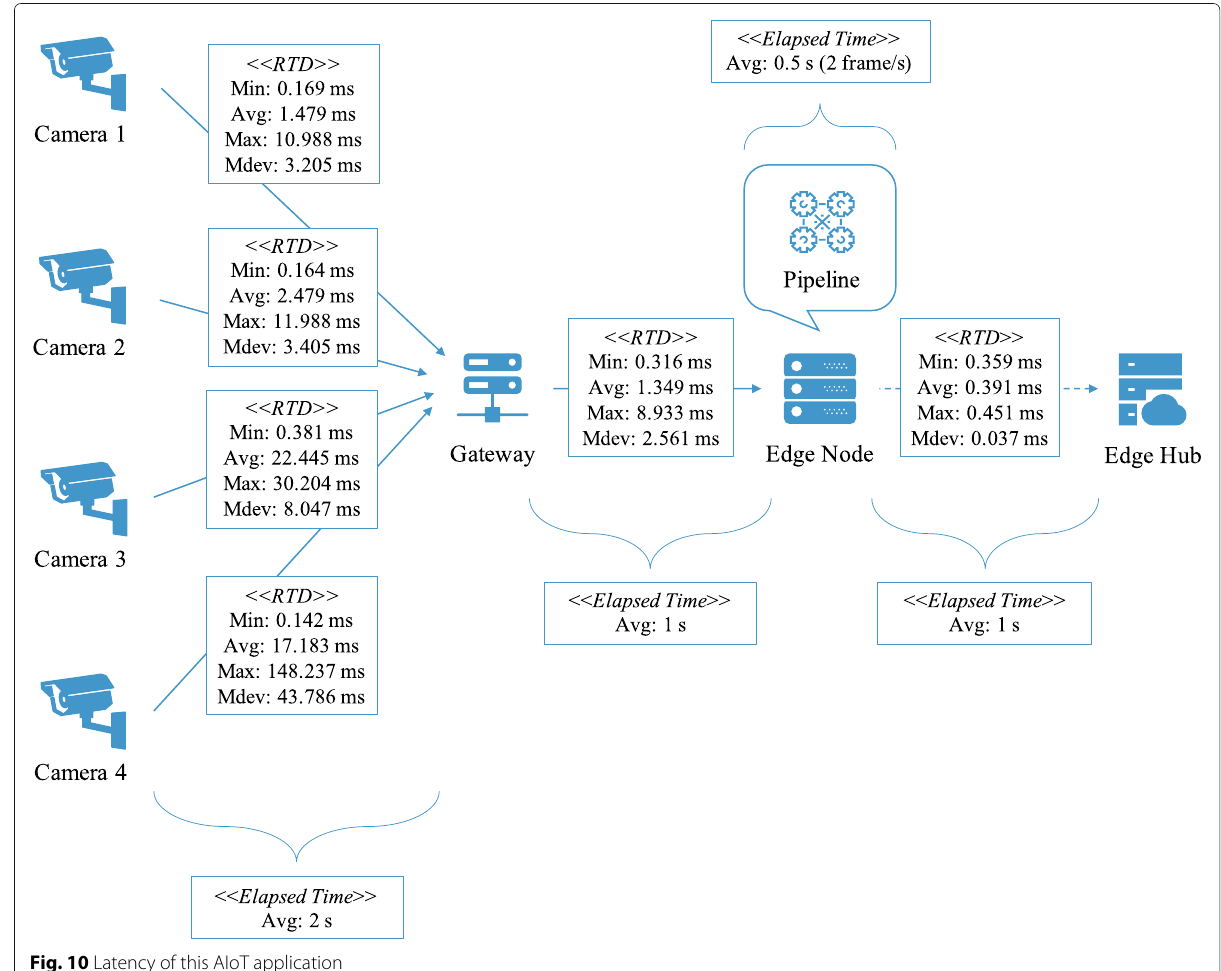
on the Edge Hub and delivered to the Edge Nodes later on. The model warehouse stores all the trained models as container images that can be quickly deployed on the Edge Nodes. The aforementioned products are also managed on the Edge Hub since the definition of products are usually able to be shared by all the Edge Nodes in a single AIoT application. The cloud infrastructure takes the responsi- bility for computing, as it usually integrates a big data backend (e.g. Spark) for data processing as well as an AI backend (e.g. Tensorflow) for model training. In addition, a monitoring mechanism is also implemented to monitor the overall state of the AIoT